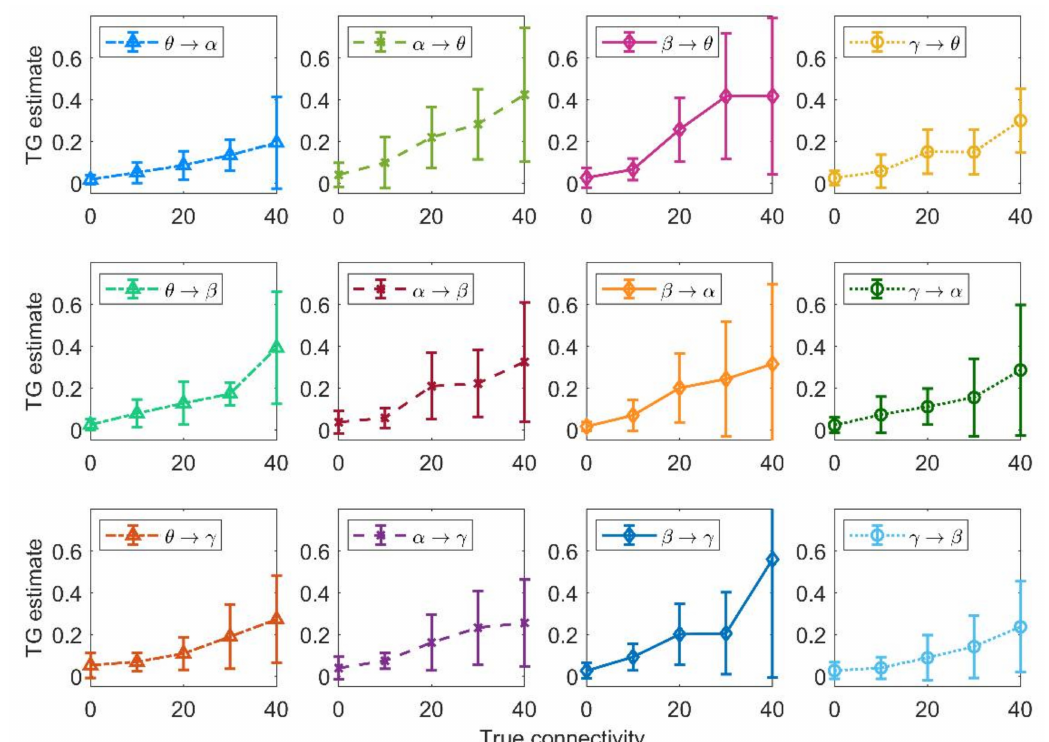
Figure 5. Relationship between the connectivity estimated with the temporal Granger causality and the true connectivity, obtained using the data from 100 randomly generated connectivity networks. It is worth noting that, in these nets, connections were randomly generated between 0 and 40 (step 10). Points are mean values at each connection strength, and bars denote standard deviations. The estimator is able to grasp the monotonic increase in connectivity. It is worth noting the large SDs occur especially when the connectivity is high and when a connection emerges from the ROI β . See